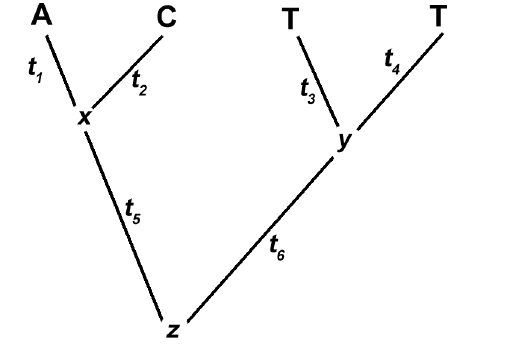
Figure 1 – Example tree with branch lengths and data at a single